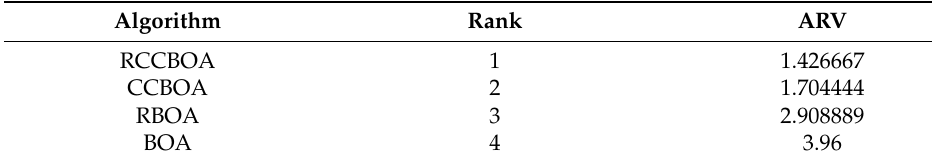
Table 4. Average ranking of four BOA variants.